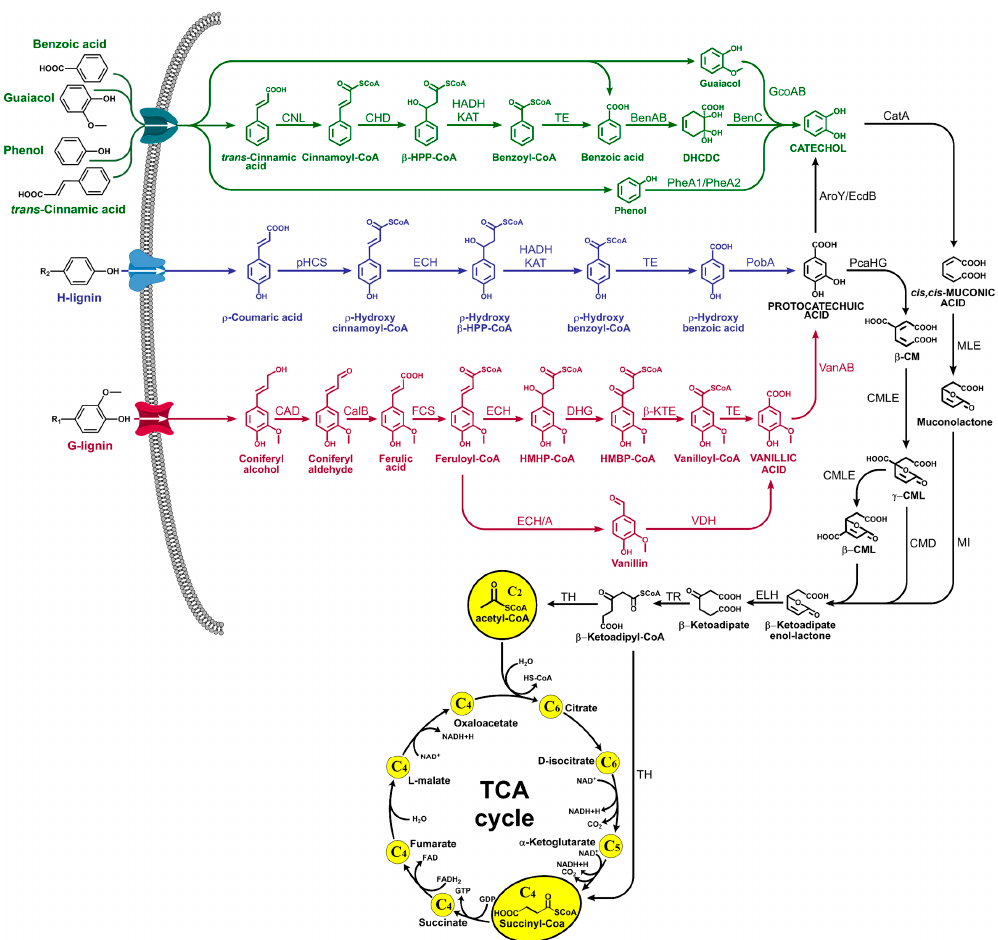
Figure 2. Scheme of the main metabolic pathways involved in the degradation of the aromatic monomers derived from lignin depolymerization. Enzymes involved in the degradation of trans- cinnamate, phenol, guaiacol and benzoate (green branch): CNL, cinnamoyl-CoA ligase; CHD, cinnamoyl-CoA hydratase/dehydrogenase; BenA, benzoate 1,2-dioxygenase subunit A; BenB, ben- zoate 1,2-dioxygenase subunit B; BenC, benzoate 1,2-dioxygenase ferredoxin reductase; BenD, 3,5- cyclohexadiene-1,2-diol-1-carboxylate dehydrogenase; PheA1, large subunit phenol hydroxylase; PheA2, small subunit phenol hydroxylase; GcoA, cytochrome P450; GcoB, cytochrome P450 reduc- tase. Enzymes involved in the conversion of cis,cis -muconic acid (black branch): CatA, catechol 1,2- dioxygenase; MLE, cis,cis -muconate lactonase; MI, muconolactone isomerase; PcaHG, protocatechu- ate 3,4-dioxygenase; CMLE, β -carboxy- cis,cis -muconate lactonase; CMD, γ -carboxy-muconolactone decarboxylase; ELH, β -ketoadipate enol-lactone hydrolase; TR, β -ketoadipate succinyl-CoA trans- ferase; TH, β -ketoadipyl-CoA thiolase. Enzymes involved in the degradation of H-lignin monomers (blue branch): pHCS, p -hydroxycinnamoyl-CoA synthetase; HADH, 3-hydroxyacyl-CoA dehydroge- nase; KAT, 3-ketoacyl-CoA thiolase; PobA, p -hydroxybenzoate hydroxylase. Enzymes involved in the degradation of G-lignin monomers (red branch): CAD, coniferyl alcohol dehydrogenase; CalB, conyferyl aldehyde dehydrogenase; FCS, feruloyl-CoA synthetase; ECH, enoyl-CoA hydratase; DHG, dehydrogenase; β -KTE, β -keto thiolase; TE, thiolase; ECH/A, enoyl-CoA-hydratase/aldolase; VDH, vanillin dehydrogenase; VanAB, vanillate demethylase A + vanillate O -demethylase oxidoreduc- tase; AroY, protocatechuate decarboxylase; EcdB, Ubix family prenyltransferase; HMHP-CoA, 3-(4- hydroxy-3-methoxyphenyl)-3-hydroxypropanoic acid; HMBP-CoA, 4-hydroxy-3-methoxyphenyl- β -ketopropionyl-CoA; β -HPP-CoA, β -hydroxy propionyl-CoA; DHCDC, 1,2-dihydroxy-cyclohexa- 3,5-diene-1-carboxylate; β -CM, β -carboxymuconate; β -CML, β -carboxymuconolactone; γ -CML, γ